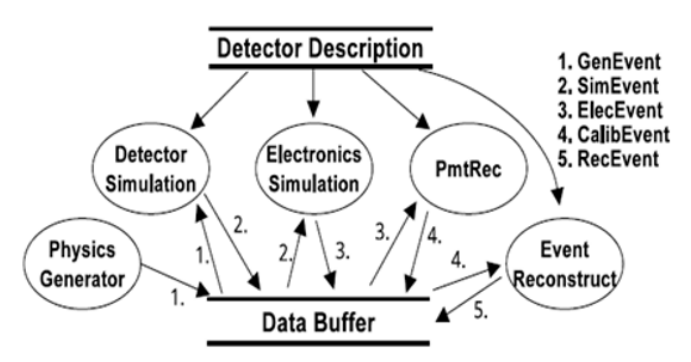
Fig. 1. Data processing steps in JUNO Monte Carlo production